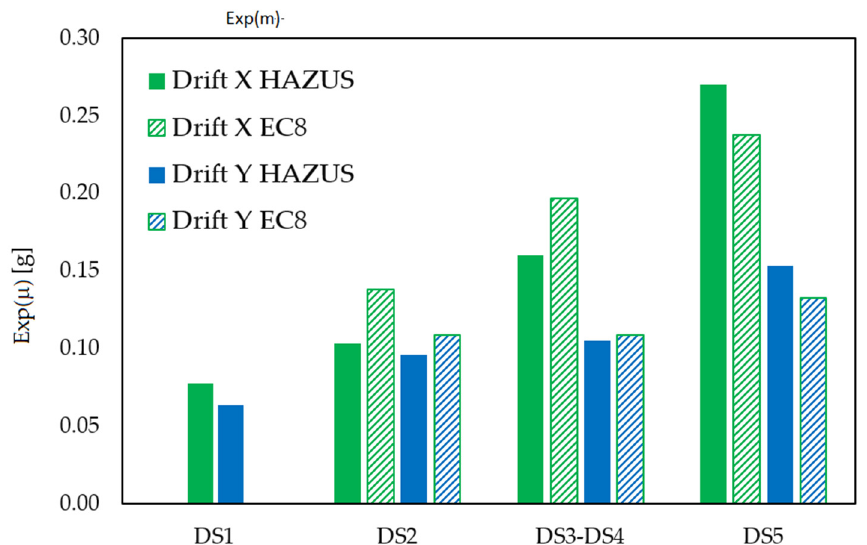
Figure 10. Median exp( µ ) of fragility curves for X and Y direction and for the adopted IDR damage state thresholds.